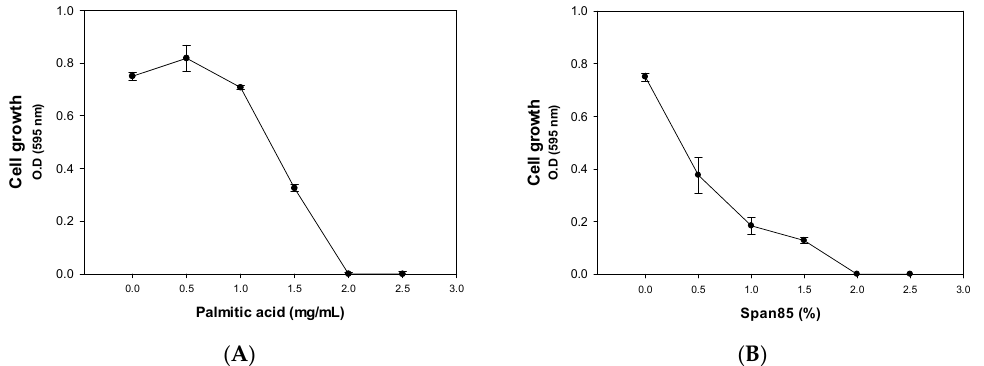
Figure 1. E ff ect of di ff erent levels of ( A ): palmitic acid and ( B ): span85 on the ∆ agr strain. Error bars Figure 1. Effect of different levels of ( A ): palmitic acid and ( B ): span85 on the Δ agr strain. Error bars represent the standard deviation of three represent the standard deviation of three replicates.